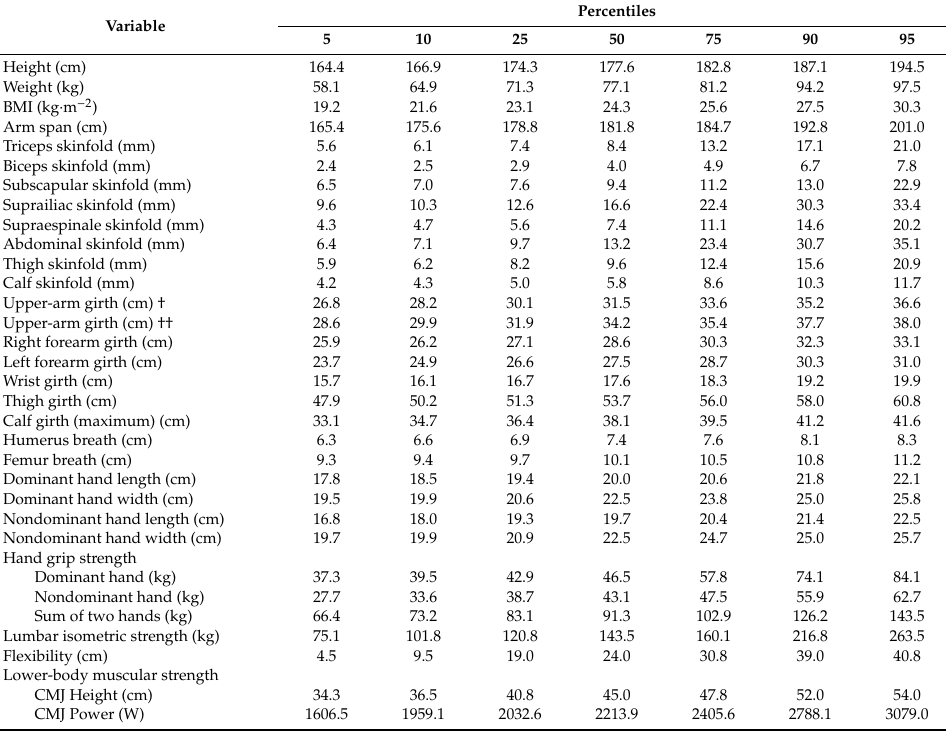
Table 2. Percentiles for the anthropometric and physical variables of elite padel players (n = 25). Variable